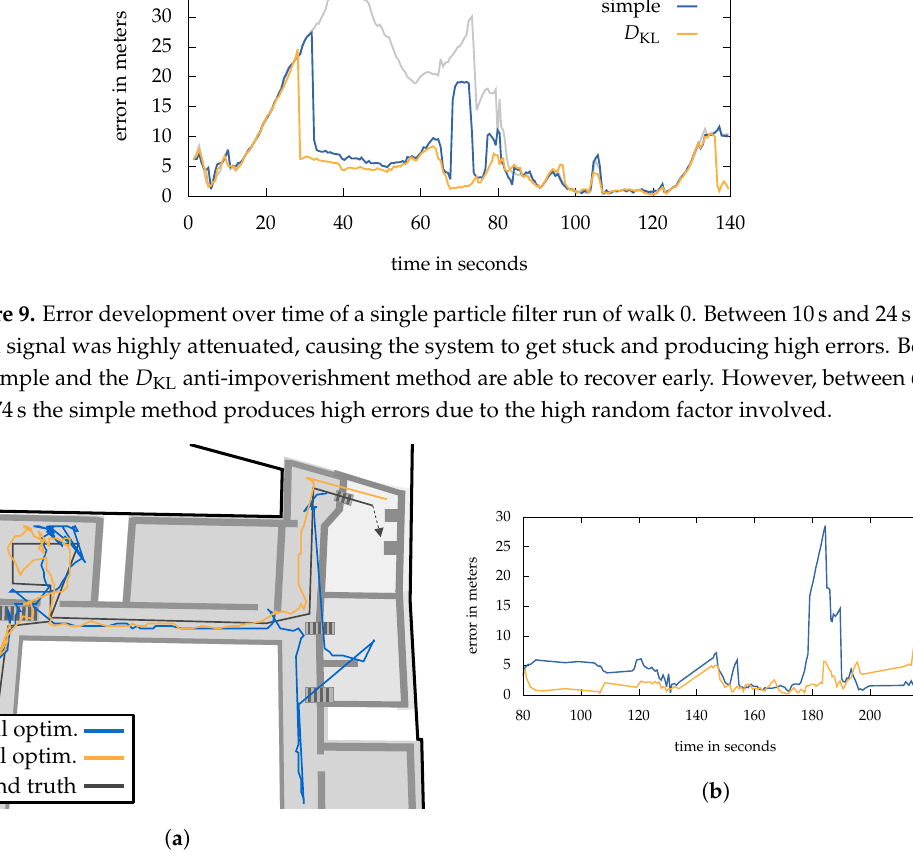
Figure 10. ( a ) A small section of walk 3. Optimizing the system with a global Wi-Fi optimization scheme (blue) causes a big jump and thus high errors. This happens due to highly attenuated Wi-Fi signals and inappropriate Wi-Fi parameters. We compare this to a system optimized for each floor individually (orange), resolving the situation a producing reasonable results; ( b ) Error development over time for this section. The high error can be seen at